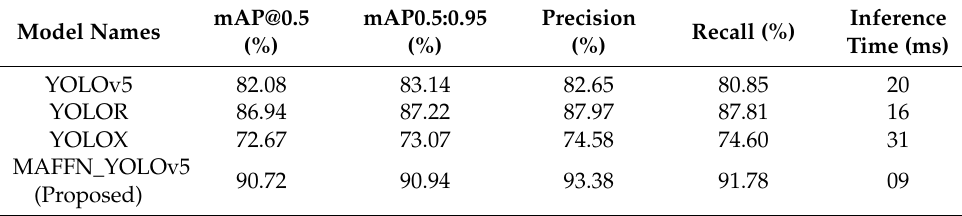
Figure 22. P-R curves of various health condition classes for the proposed model. Table 3. Quantitative comparison of the proposed and other object detection